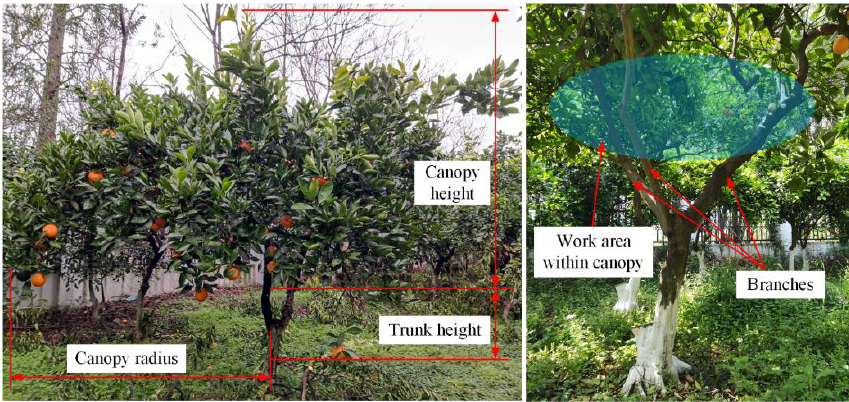
Figure 1. Example of a single dwarf citrus tree.